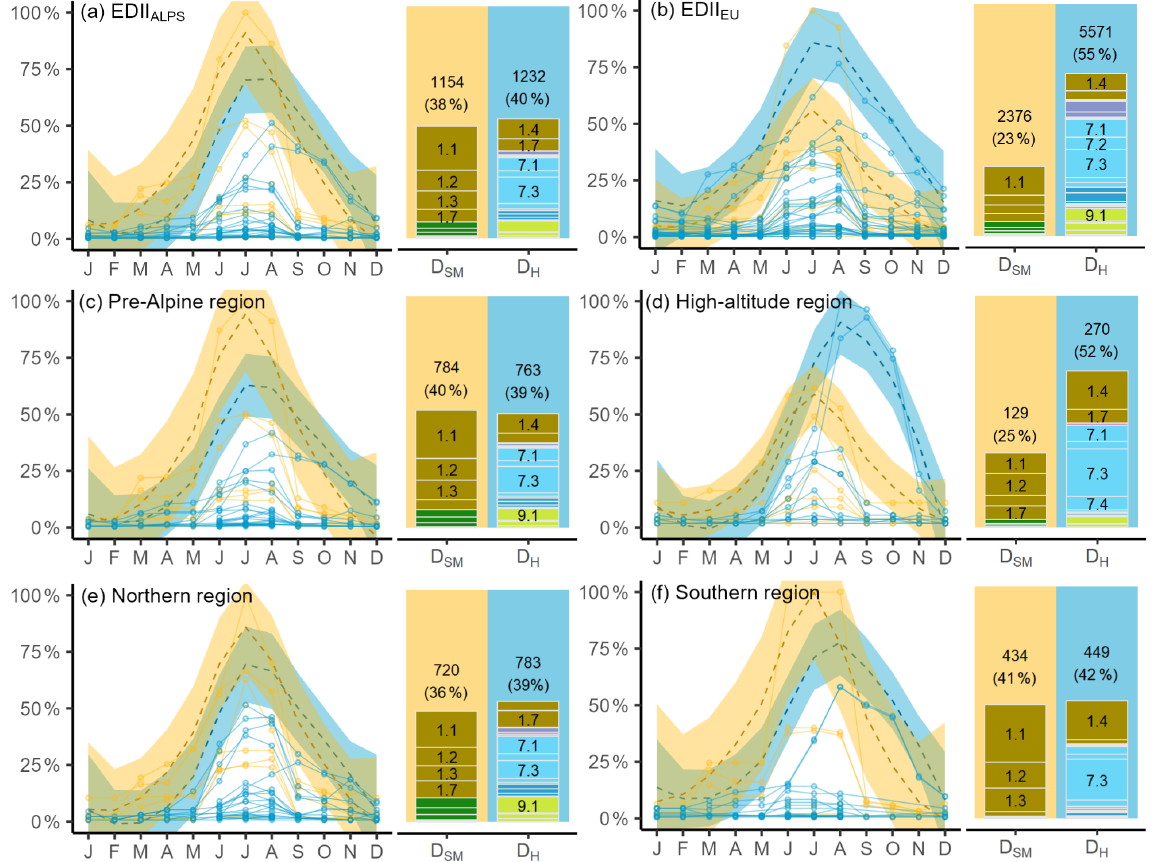
Figure 5. Impact subtypes assigned to D SM (yellow) or D H (blue) per month (line diagram) and drought type (bar plot) for the (a) EDII ALPS , (b) EDII EU , (c) pre-Alpine region, (d) high-altitude region, (e) northern region and (f) southern region. Seasonal regimes for D SM (yellow lines) and D H impacts (blue lines) are loess curves with standard errors (dotted line with coloured shape). Monthly percentages (solid lines) relate to the sum of all impacts per month and subtype, with 100% corresponding to the month with most impacts. Total counts of D SM and D H impacts are given on top of the bars; the fraction in parentheses relates to the number of impacts assigned to the season. Subtypes with a fraction ≥ 5% are labelled. For an explanation of the colours, see Fig.